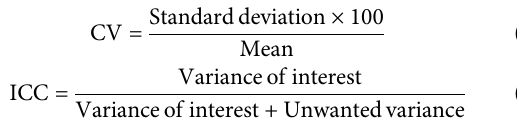
The seven matrices generated are provided in supporting information ( Supplementary Table S2